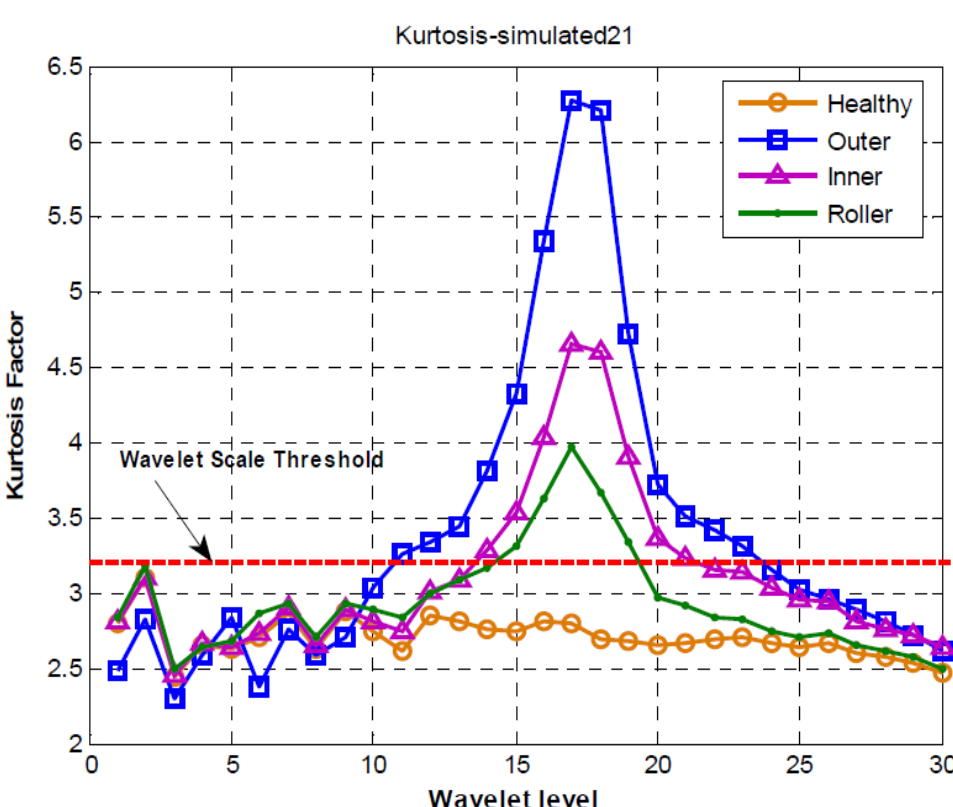
Figure 39. Laplace wavelet kurtosis for the diagnosis of multiple bearing faults [106].